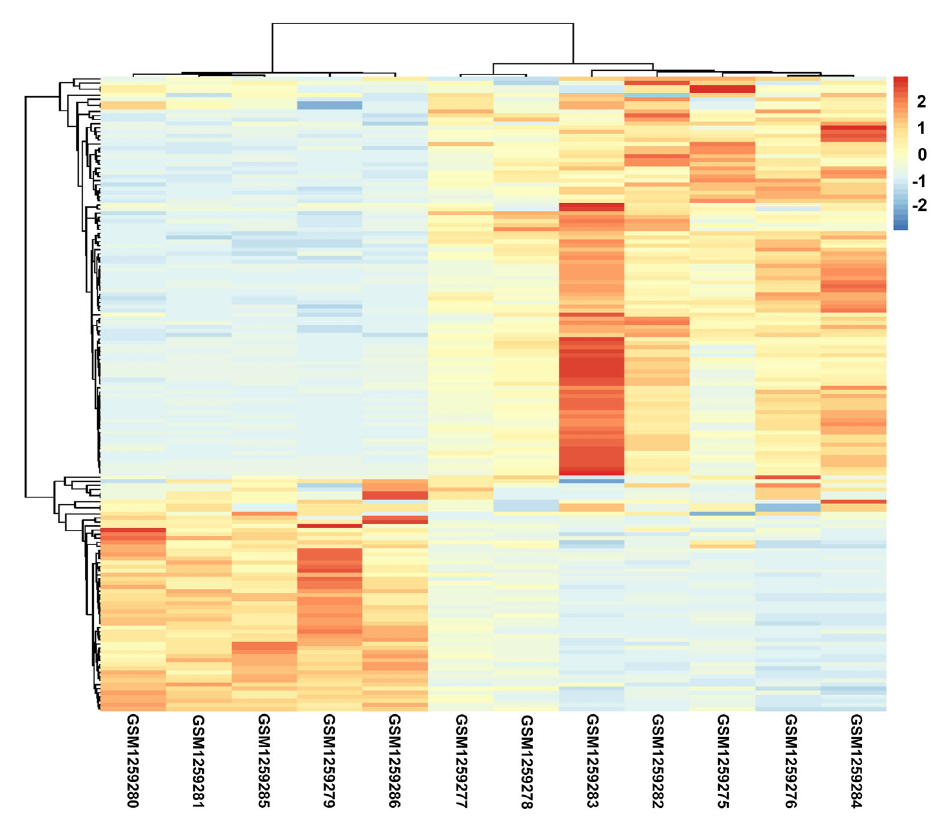
Figure 1. Hierarchical cluster analysis of the differentially expressed genes. GSMxxxxxxx: the accession number of a certain sample in the Gene Expression Omnibus database. GSM1259279 – 1259281, GSM1259285, and GSM1259286 represent normal samples, while GSM1259275 – 1259278 and GSM1259282 – 1259284 represent acute type A aortic dissection samples. The blue and red bars represent low and high expression levels,